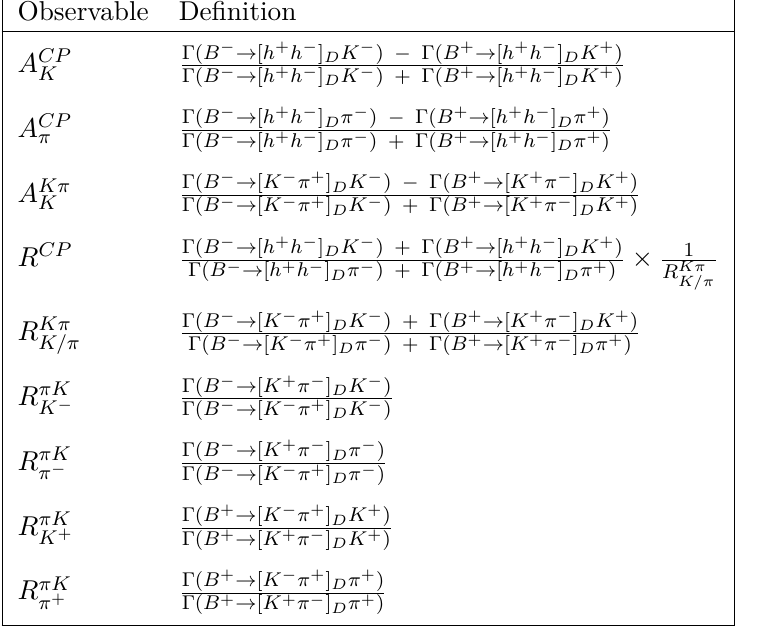
Table 1 . The nine CP observables measured using B − → Dh − decays, defined in terms of B meson decay widths. Where indicated, h + h − represents an average of the D → K + K − and D → π + π − modes. The R observables represent partial width ratios and double ratios. The A observables represent CP